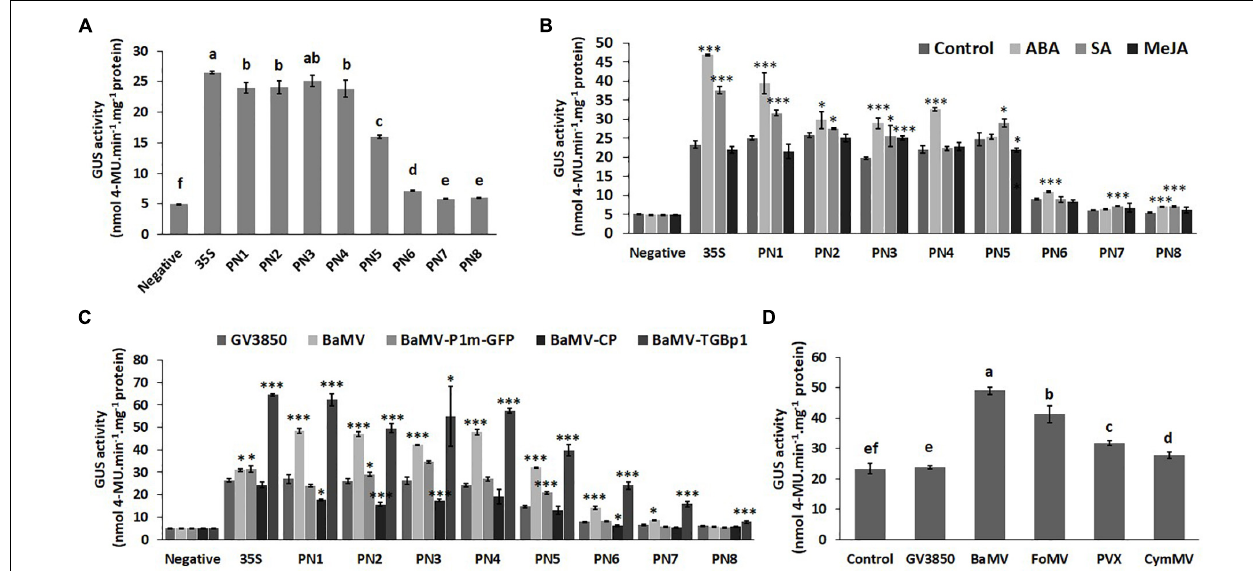
FIGURE 4 | Promoter activity of NbAGO5 under normal condition, hormone treatments, and challenge with the virus in Transgenic N. benthamiana. (A) The fluorometric GUS assays were performed with leaves of transgenic N. benthamiana harboring different constructs under normal conditions and (B) hormone treatments. (C) The GUS activities in the plants infiltrated with A. tumefaciens harboring infectious construct of BaMV or expression vector for BaMV-CP or BaMV-TGBp1 were analyzed at 3 dpi. (D) PN4 transgenic N. benthamiana plants were agro-infiltrated with infectious constructs of various potexviruses, including BaMV, PVX, FoMV, and CymMV. The GUS activities were then analyzed at 3 dpi. Each column represents the mean of at least three replicates ± standard error (SE). Statistical significance was analyzed using two-tailed student’s t -tests; ∗ p < 0.05; ∗∗ p < 0.01; ∗∗∗ P < 0.001. The different lowercase letters above the bars indicate statistically significant differences among the means based on two-way ANOVA followed by Duncan’s multiple range test ( P <